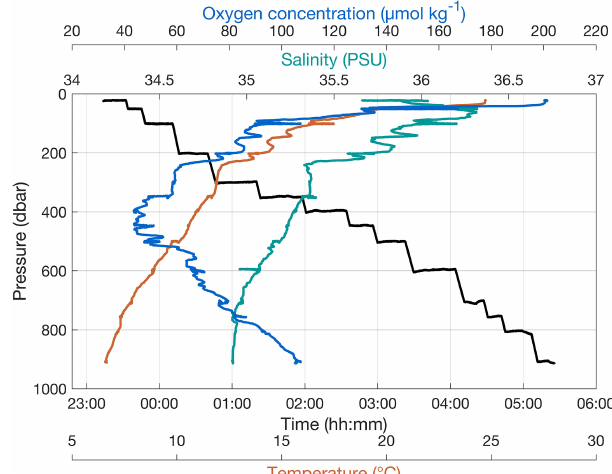
Figure 2. Stairwise trajectory of PELAGIOS through the water col- umn, to the desired depths with concomitantly measured environ- mental